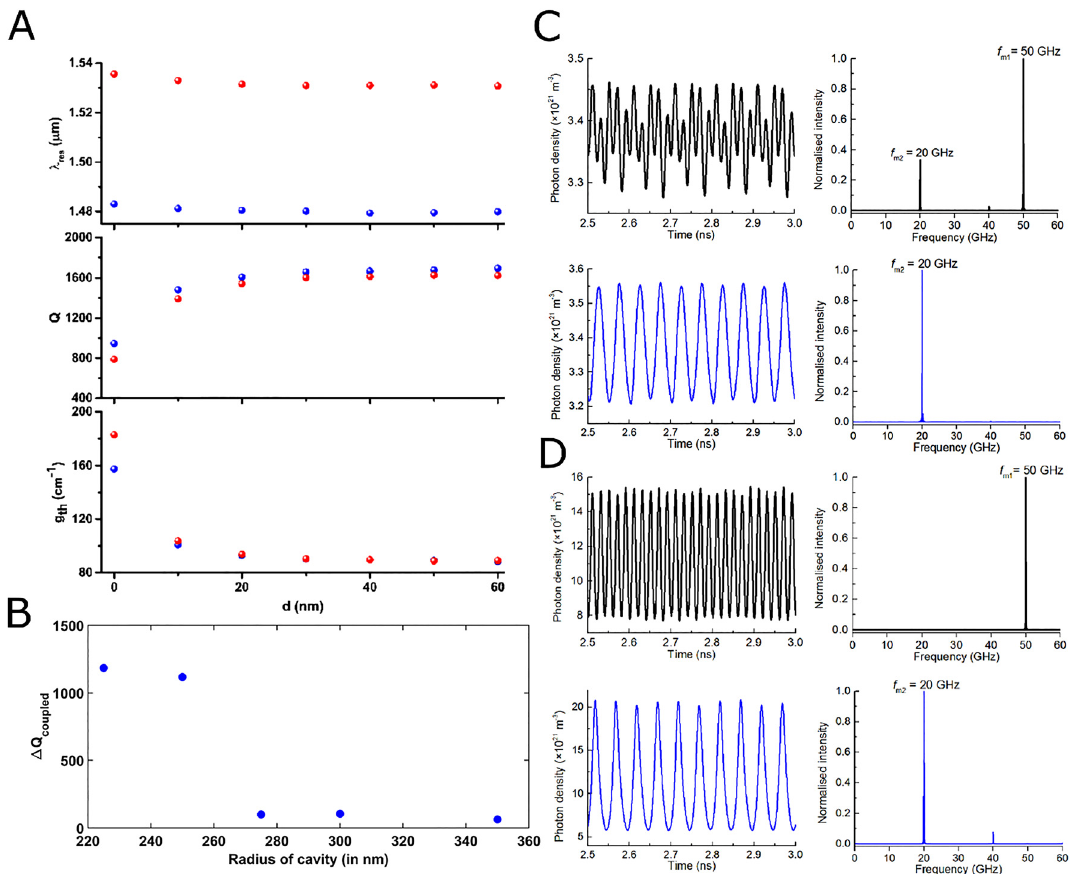
Figure 4: Cross talk isolation techniques. (A) Eigenmode wavelengths ( λ ), quality factors ( Q ), and gain thresholds ( g th ) for the two modes supported in two unequal sized metallo- dielectriccavities,whereoneis5%largerinradius.UnlikeinFigure1C,nopronouncedsplittingisobservedduetoreducedcoupling.Adapted from a study by Deka et al. [35] with permission. (B) Difference in Q for the coupled mode – Δ Q coupled – for d = 100 nm and d = 0 nm as a function of radii of the cavities. Larger sized cavities impede coupling. Reprinted from a study by Deka et al. [55] with permission. (C) Photon densities (left) and their Fast Fourier Transforms (FFTs, right) for two mutually coupled nanolasers in unidirectional isolation. Laser 1 (top) is affectedbydynamicsoflaser2(bottom)butnotviceversa.(D)Sameas(C)butnownanolasersareinbidirectionalisolationregime.Eachlaser is unperturbed by dynamics of its neighbor. (C) and (D) reprinted from a study by Han et al. [56] with